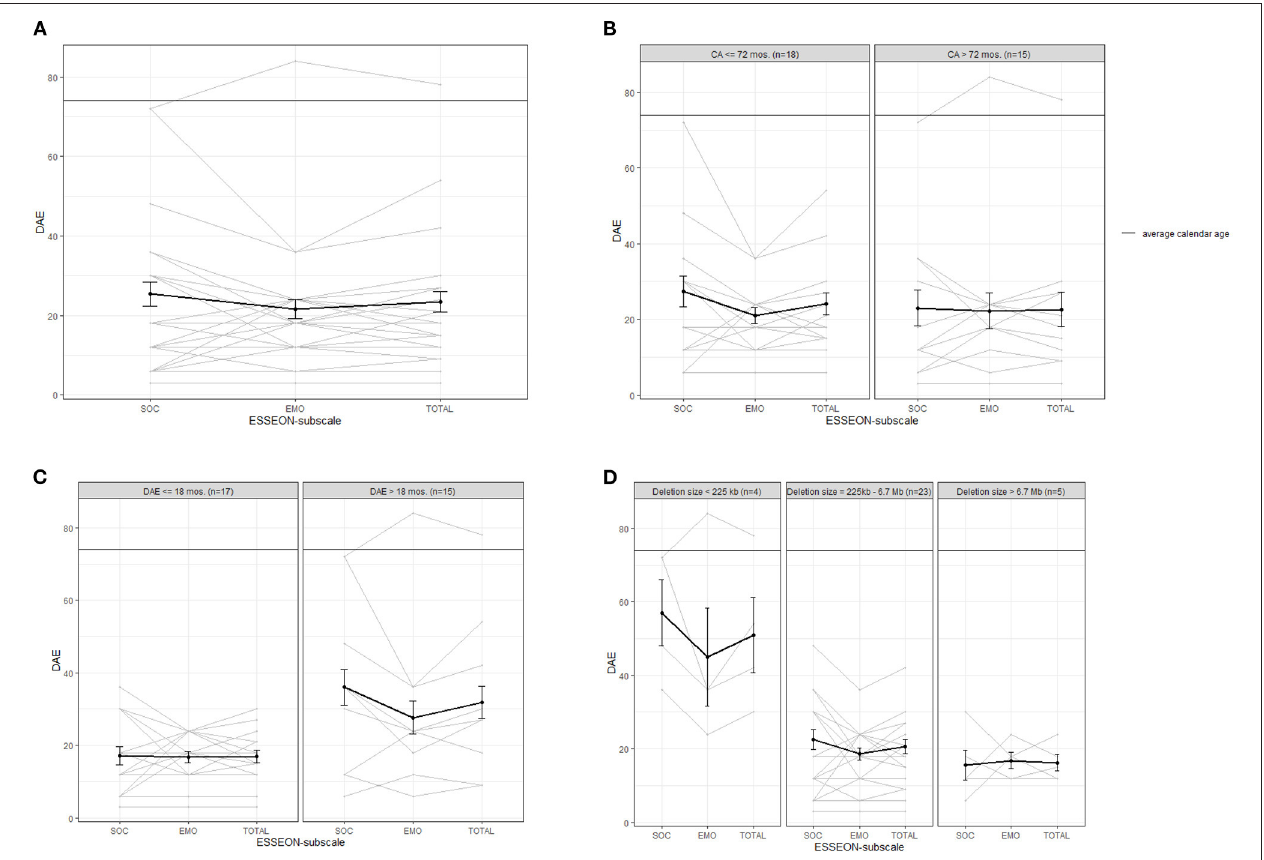
FIGURE 4 | Average (bold line) and individual behavior profiles on the ESSEON-R for (A) the whole sample and for subgroups based on (B) calendar age (CA), (C) developmental age equivalent (DAE) in months based on the Bayley-III cognition scale and (D) deletion size. SOC, social development; EMO, emotional